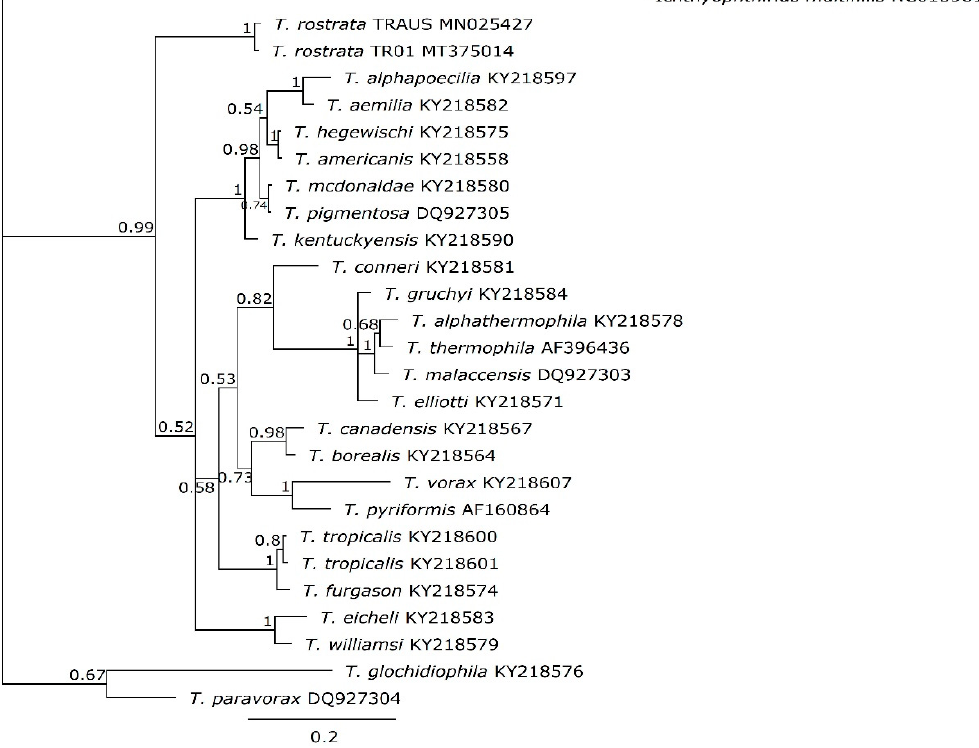
Figure 6. Phylogenetic tree of Tetrahymena based on the mtSSUrRNA, 541 bp right-hand region of TRAUS, TR01 and other Tetrahymena species. The MrBayes tree was built in Geneious Prime v.1.2 using a 1,100,000-generation chain length and a 1,000,000-generation burn-in with Ichthyophthirius multifiliis as an out group. Posterior probability values are shown to indicate branch support.